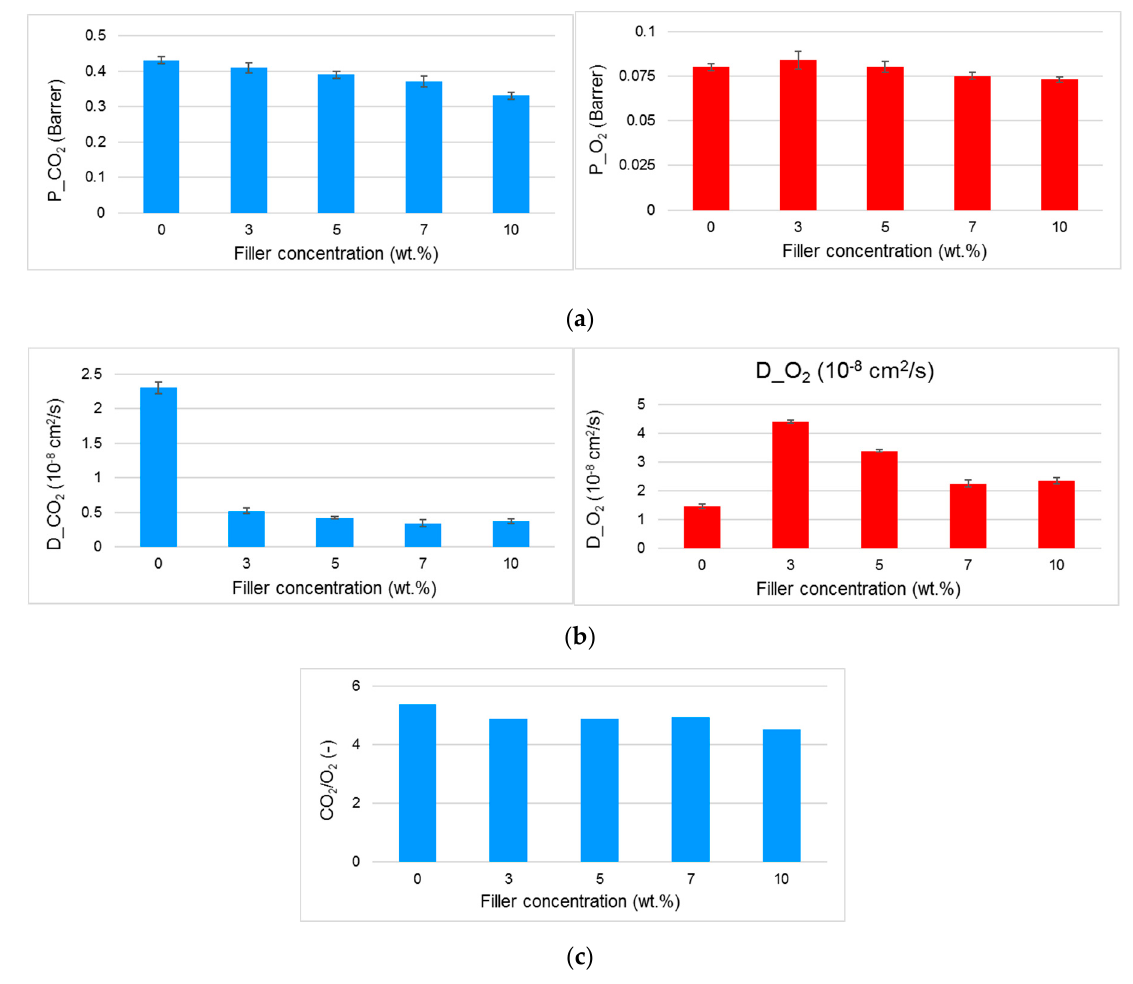
Figure 8. Transport parameters for CO 2 and O 2 measured at 25 °C on films based on PA11 and composite materials (PA11 + Zeo-Sal). ( a ) Permeability; ( b ) diffusion coefficient; ( c ) permselectivity.